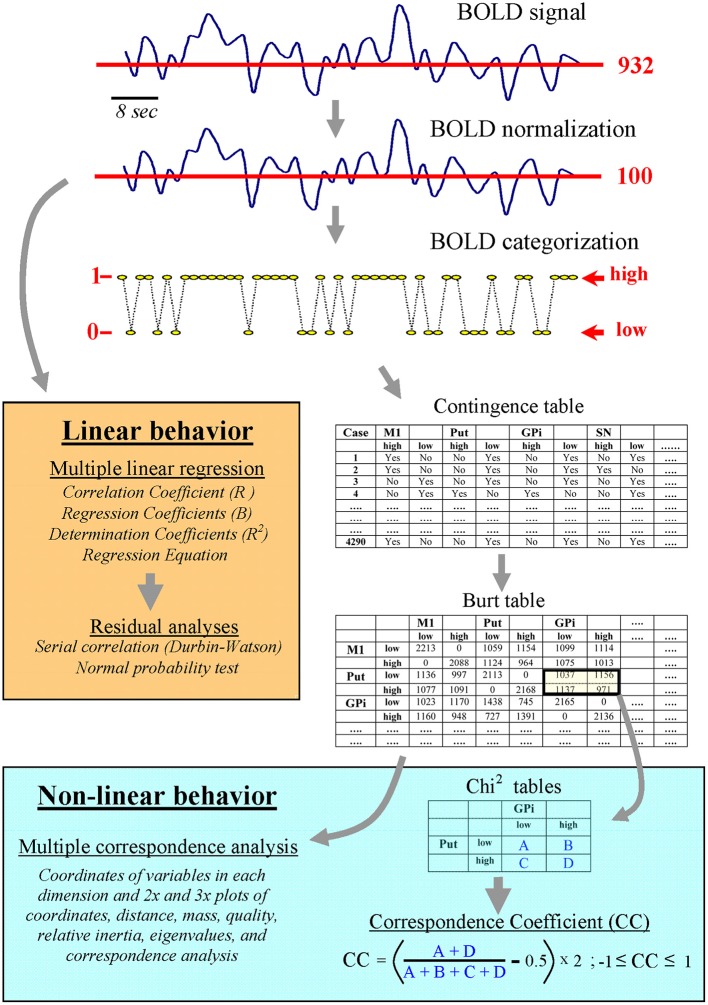
Linear and non-linear computing methods for analyzing the normalized and the categorized BOLD-signal.